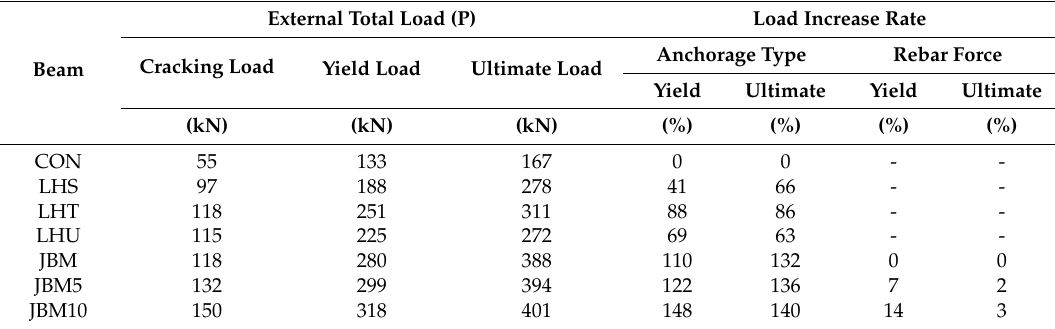
Table 3. Test results.